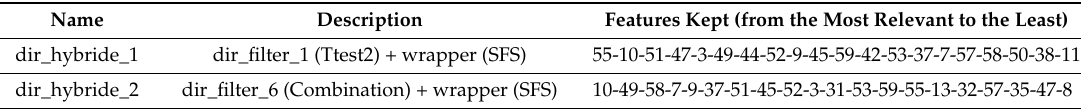
Table A3. Features kept with the hybrid feature selection